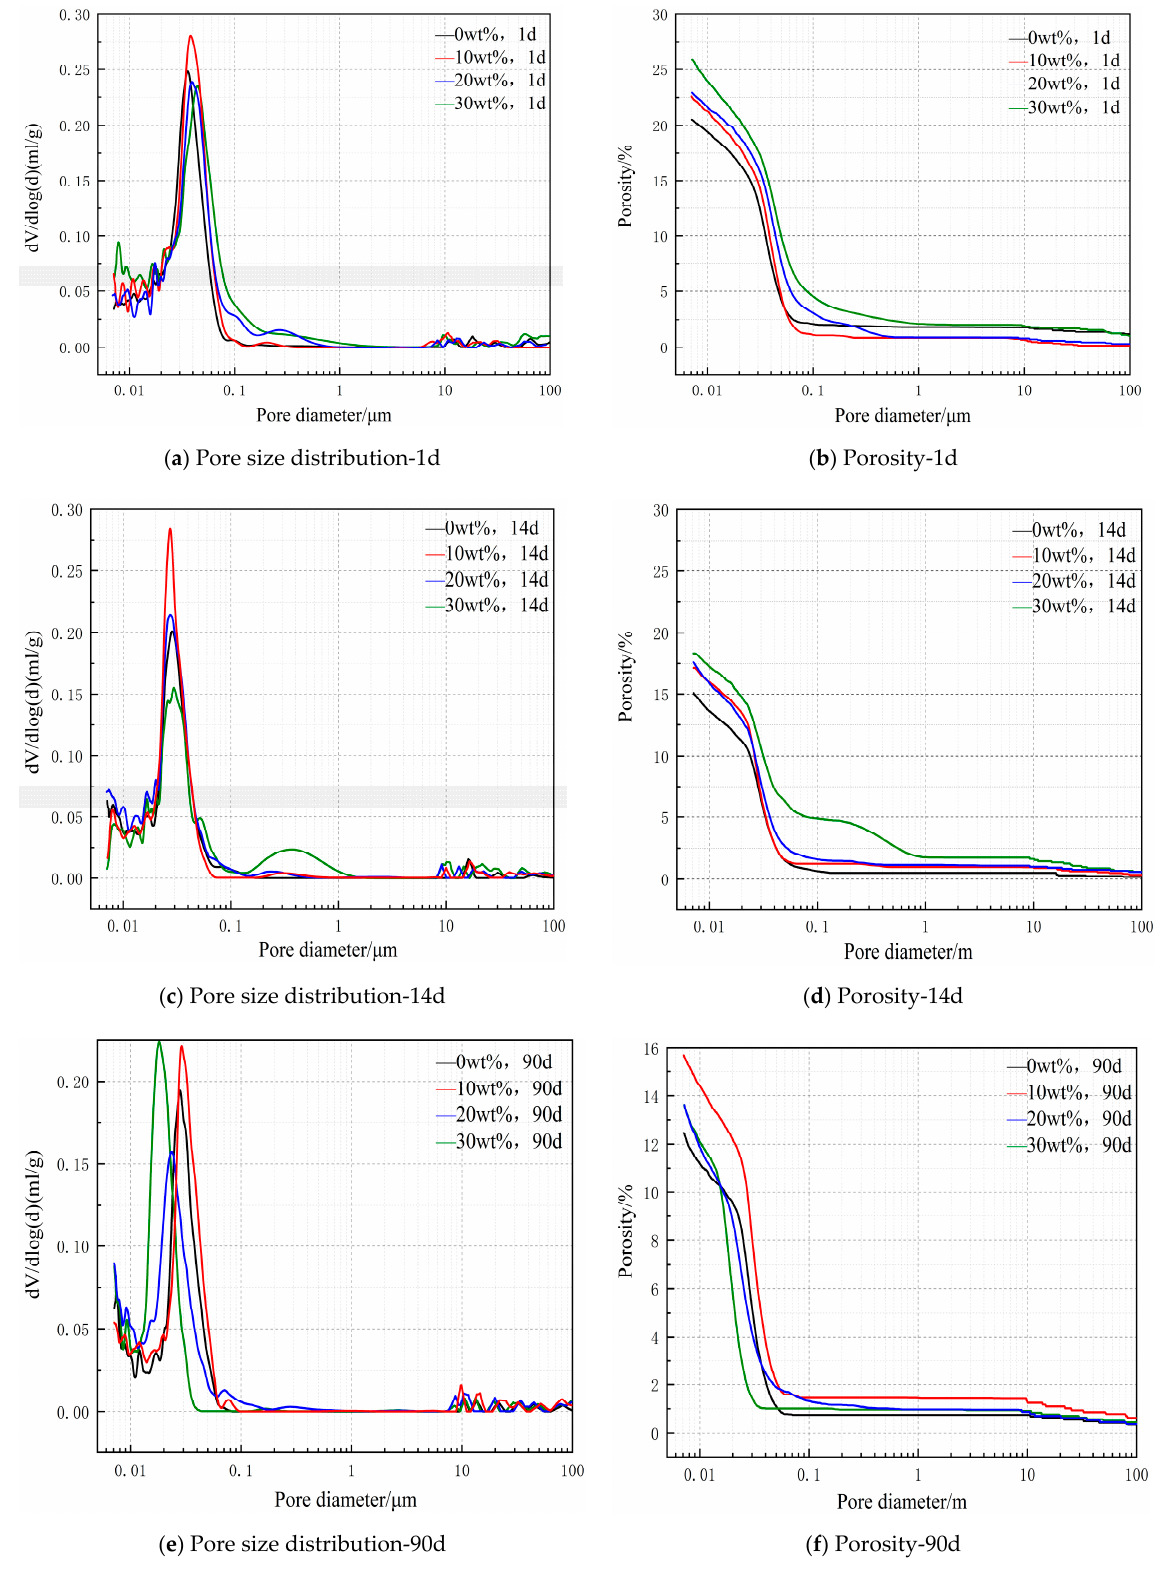
Figure 7. Pore size distribution and cumulative porosity of cement paste samples with different dosages after curing.